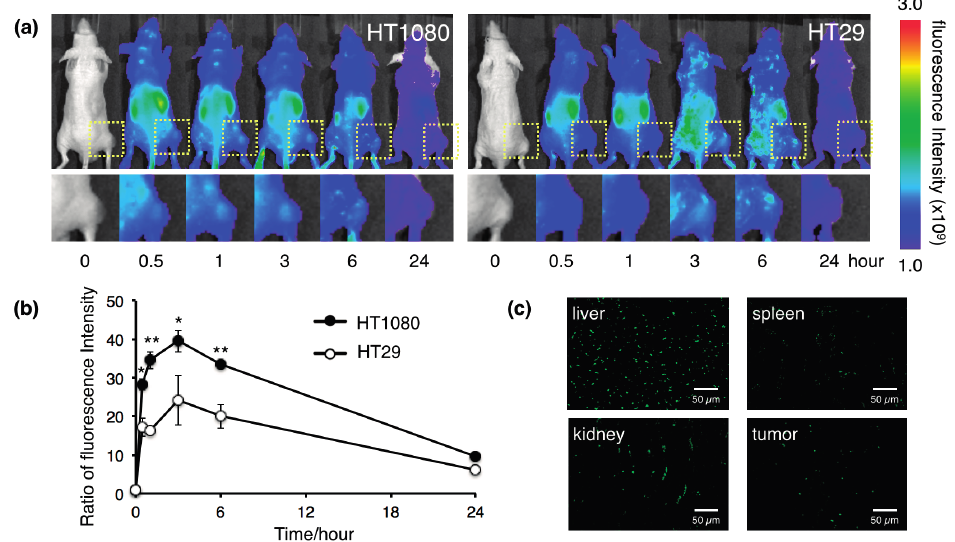
Figure 5. Biodistribution of the protein nanocages in vivo . ( a ) In vivo real-time NIR fluorescence imaging of intravenously injected Alexa Fluor 750-labeled HspG41C-CTT in HT1080 and HT29 tumor-bearing mice. Time-dependent, tumor-targeting specificities of the nanocages were monitored by the IVIS system. Square regions indicate solid tumor growths of subcutaneously injected cancer cells; ( b ) Fluorescence signal intensity ratio of the tumor/background obtained from in vivo images. * p < 0.05; ** p < 0.01; ( c ) Organ sections of tumor-bearing mice injected intravenously with Alexa Fluor 488-labeled HspG41C-CTT at 3 h